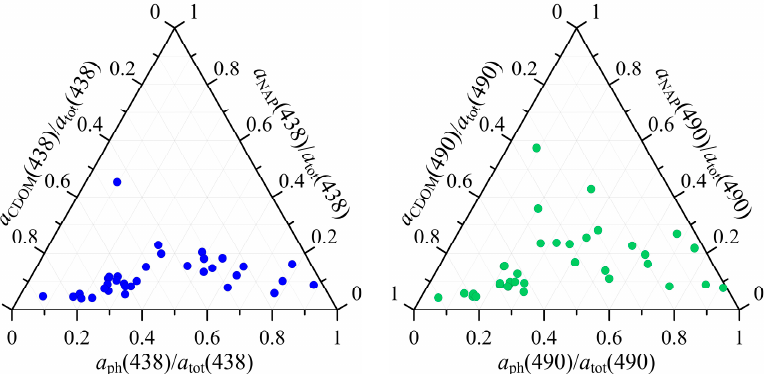
Figure 11. Contribution of phytoplankton ( a ph ( λ ) / a tot ( λ ) ), non-algal particles ( a NAP ( λ ) / a tot ( λ ) ), and coloured dissolved organic matter ( a CDOM ( λ ) / a tot ( λ ) ), to the total non-water absorption at 438 nm (blue symbols) and at 490 nm (green symbols) in the surface layer of the Southern Ocean from 11 January–4 February 2020.